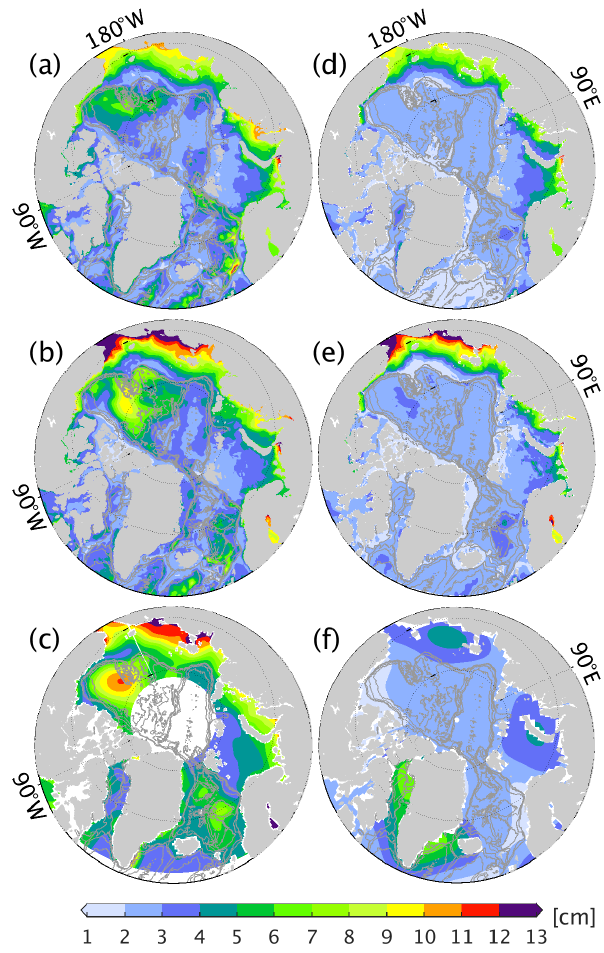
Figure 2. The rms variability of (a–c) sea level and (d–f) bottom pressure in (a, d) ATLARC08km, (b, e) ATLARC04km, (c) satellite altimetry, and (f) GRACE. We computed the rms variability using monthly data from January 2003 to December 2011. Bathymetry contours of 500, 1000, 2000, and 3000m are drawn with gray